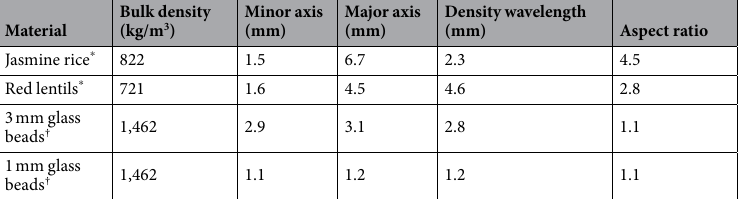
Table 1. Properties of the grains used in the experimental campaign, as measured by micrometer ( * ), static optical image analysis ( † ) and X-ray density wavelength, and described in the Methods